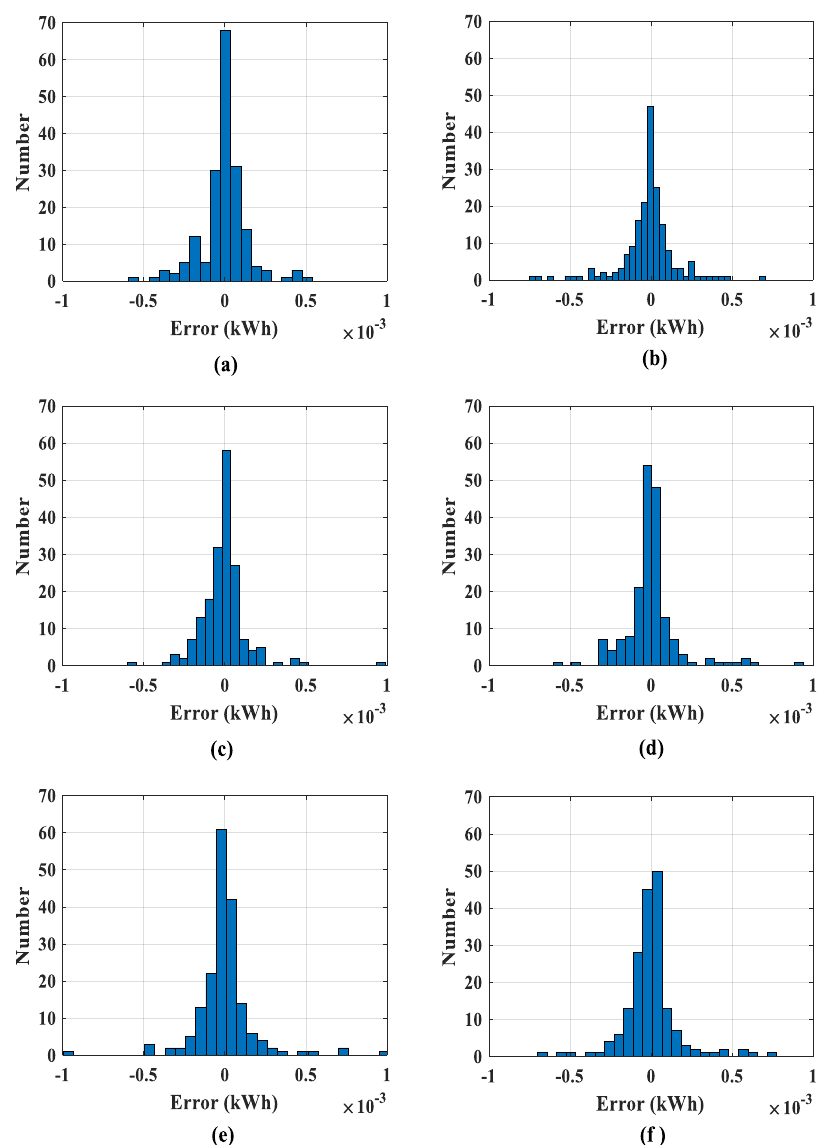
Figure 7. The error distribution of wavelet-ANFIS and ANFIS with 18 input patterns: ( a ) 10 min ahead forecasting using wavelet-ANFIS model; ( b ) 10 min ahead using ANFIS model; ( c ) 30 min ahead forecasting using wavelet-ANFIS model; ( d ) 30 min ahead using ANFIS model; ( e ) 60 min ahead forecasting using wavelet-ANFIS model; ( f ) 60 min ahead using the ANFIS model.